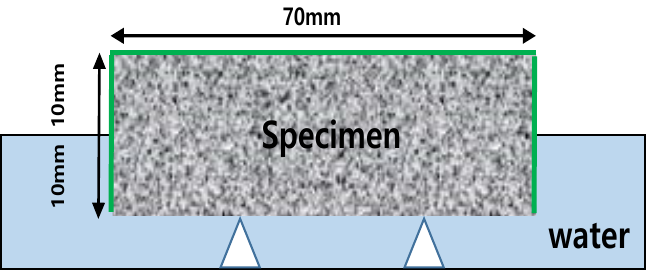
Figure 5. Water absorption test equipment.